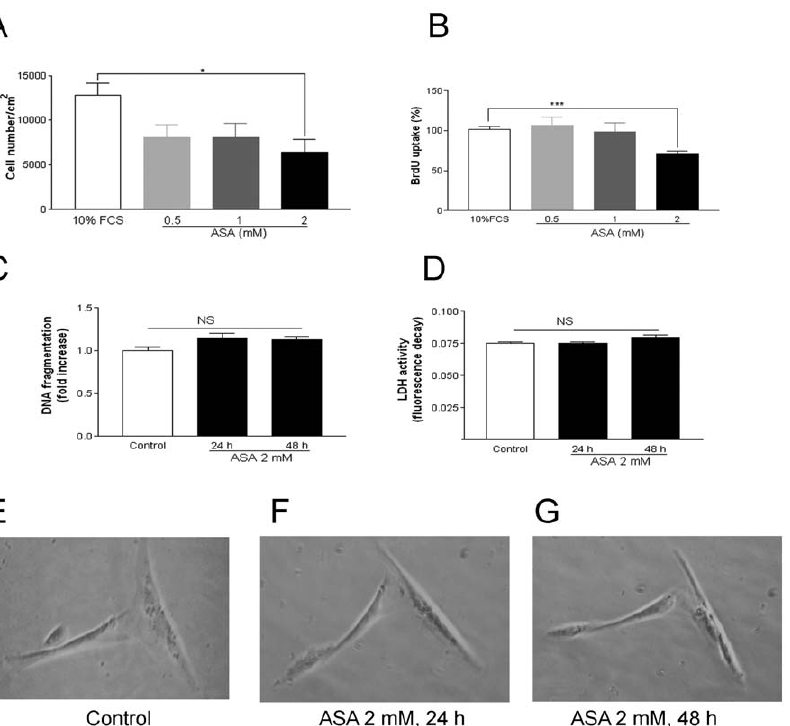
Figure 1. Effects of ASA on human vascular smooth muscle cell proliferation and death. Panel A: Cells were incubated with ASA at 0.5, 1 or 2 mM and counted. Panel B: Concentration-dependency of ASA effect on DNA synthesis. Panel C: Effect of ASA (2 mM) on DNA fragmentation. Panel D: Effect of ASA (2 mM) on LDH activity. Panel E: Photomicrograph shows VSMC cultured in ASA-free10% FCS medium. Panel F: Effect of ASA (2 mM, 24 h) on cell morphology. Panel G: Effect of ASA (2 mM, 48 h) on cell morphology. Bar graphs show the mean 6 S.E.M of n=4 experiments (cell cultures from 4 different patients). * P , 0.05, *** P , 0.001.